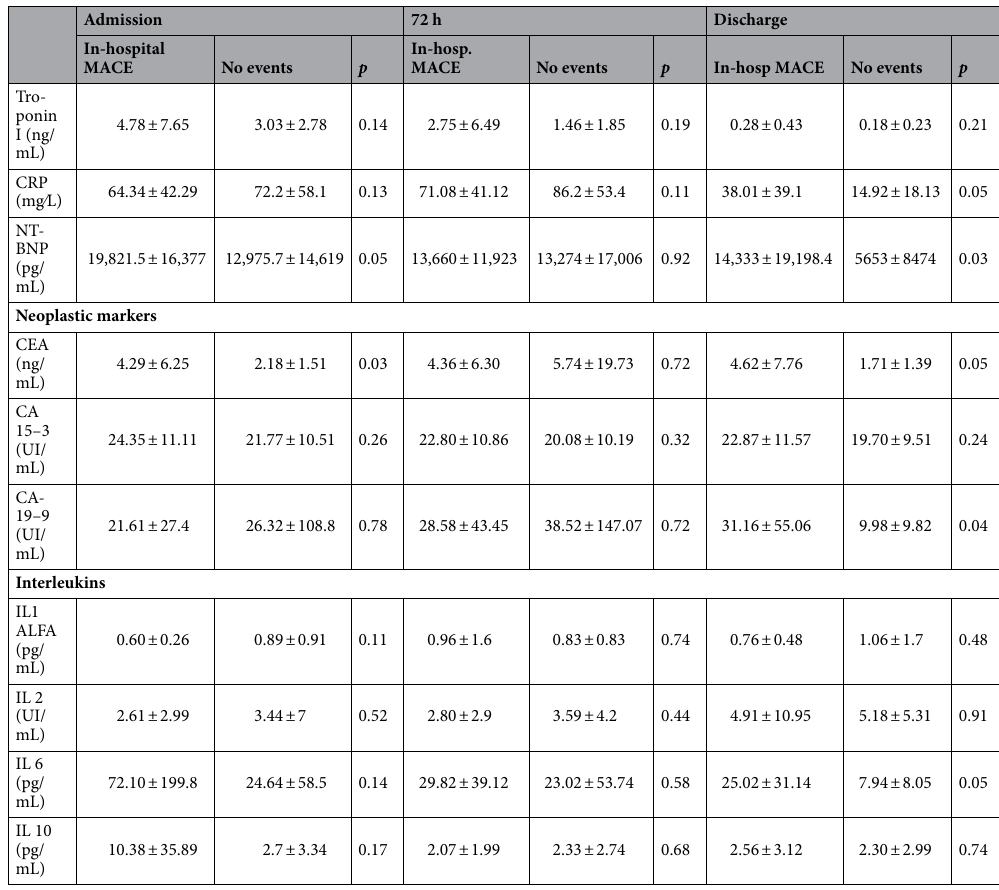
Table 2. Laboratory parameters of patients with events versus without events during hospitalization. MACE mayor cardiac adverse event.